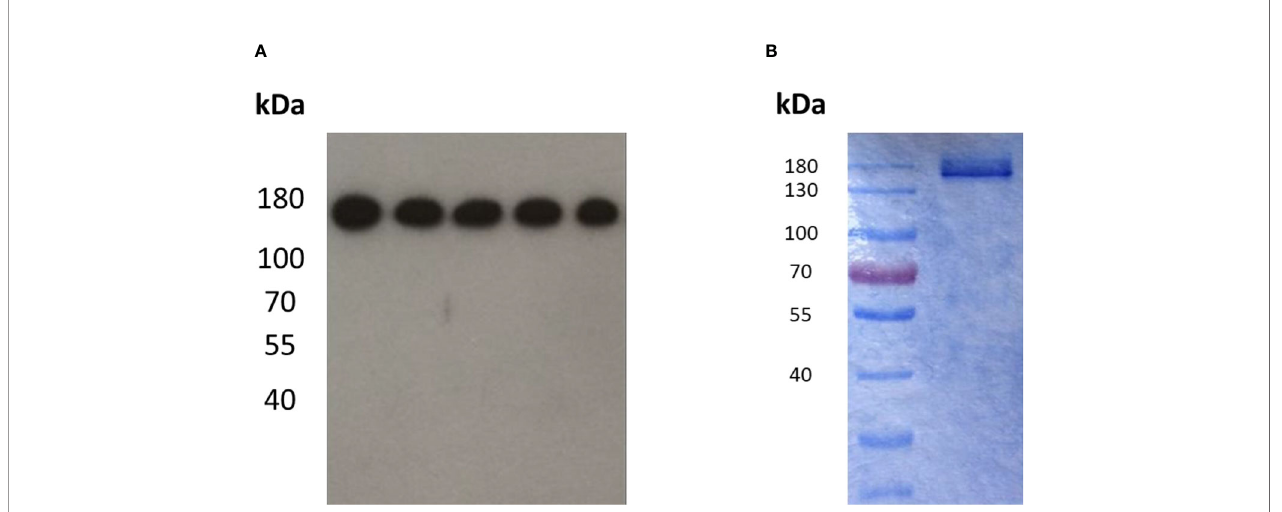
FIGURE 4 | Detection of the IgG1-format neurabin-I BAR-body in Western Blot analysis using anti-Flag antibodies (A) and in Coomassie Blue staining (B). Both analyses show the estimated molecular weight of the IgG1-format BAR-body of approximately 150 kD comparable to normal IgG antibodies.